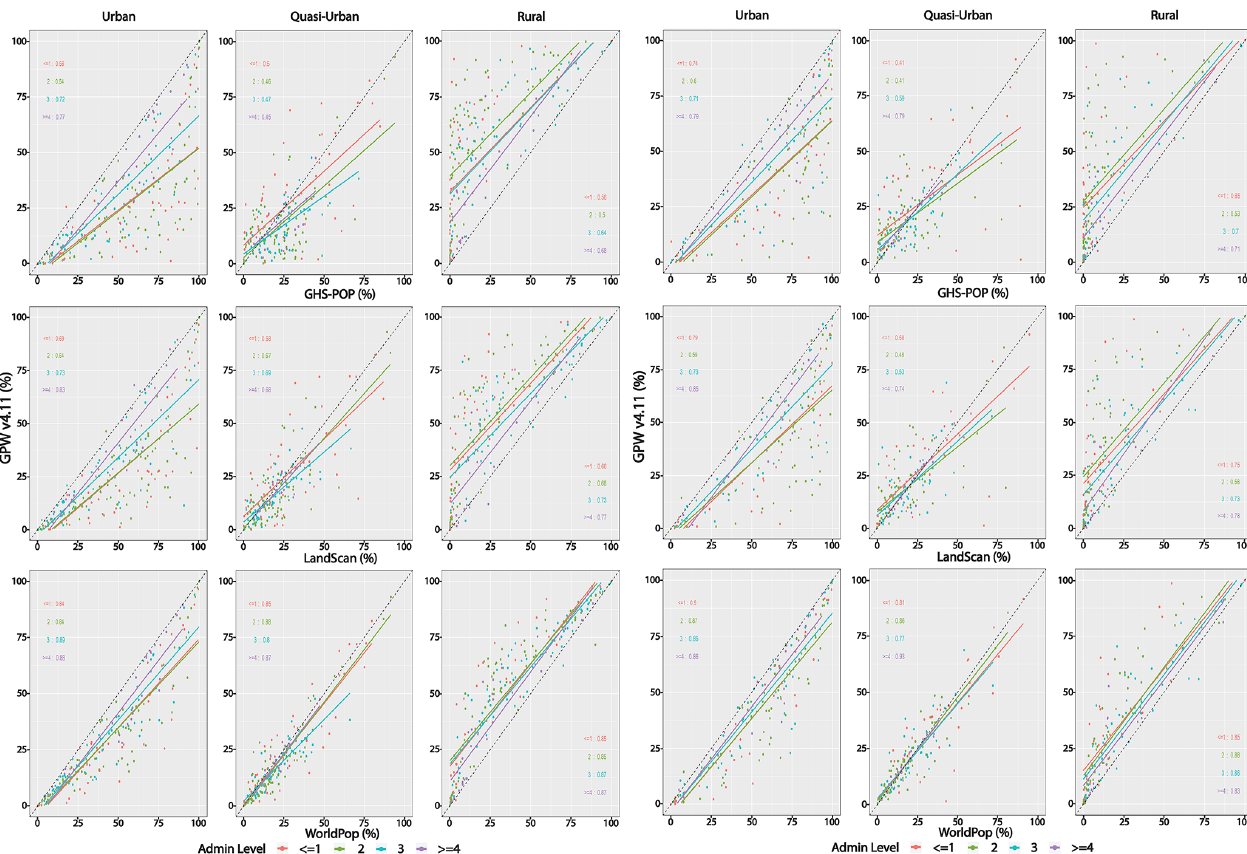
Figure B8. Comparison of population data sources by level of input unit in GPW, by urban–rural classes and urban-proxy data sets (dLIGHT). The left panel shows all land areas; the right panel shows only under 10m (LECZ).